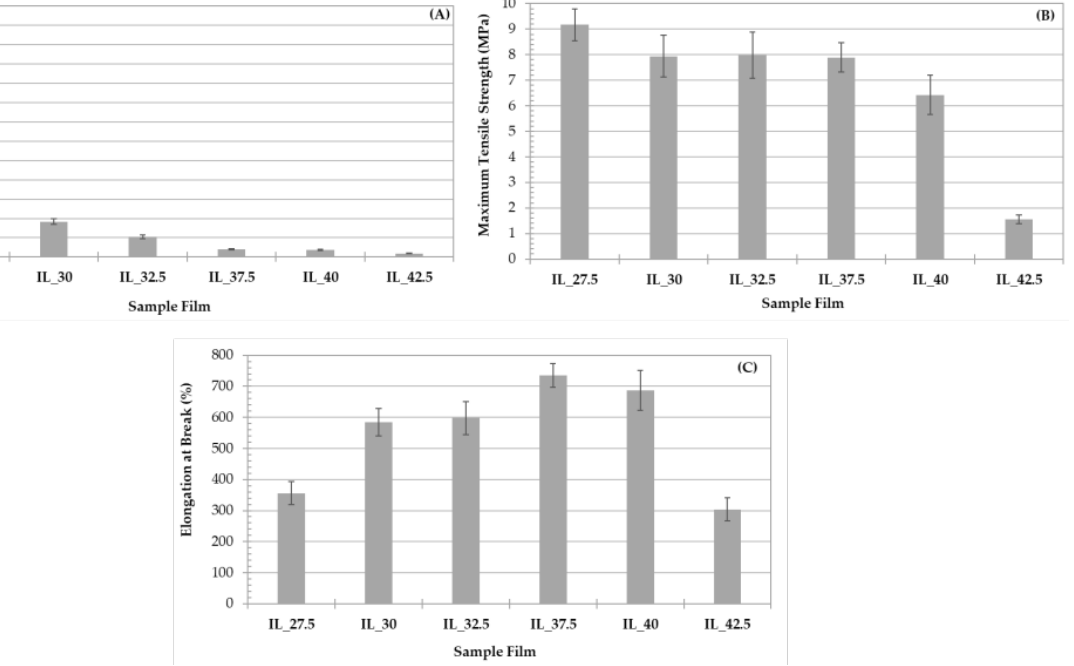
Figure 3. Mechanical properties of the films studied. ( A ) Young’s modulus; ( B ) Maximum Tensile Strength; and ( C ) Elongation at break.